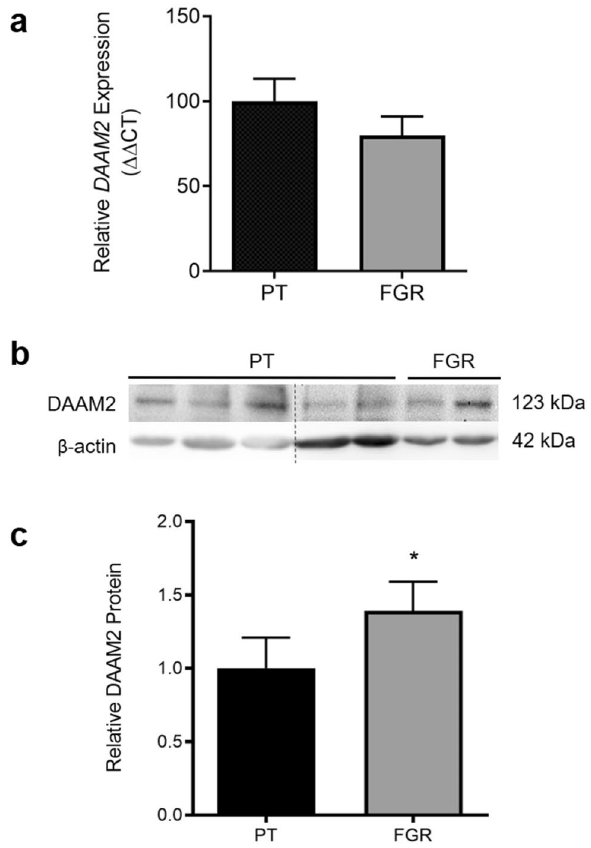
Figure 3. DAAM2 mRNA and protein in preterm placental tissue (≤ 34 weeks). ( a ) DAAM2 mRNA expression assessed by qPCR. ( b ) Representative western blot and ( c ) densitometric analysis of DAAM2 protein. DAAM2 mRNA expression was not significantly changed in fetal growth restricted (FGR; n = 14) tissue compared to preterm control (PT; n = 10) tissue. Relative levels of DAAM2 protein were significantly higher in fetal growth restricted (n = 16) placental tissue compared to preterm control (n = 9) tissue. Protein and mRNA data presented as fold change from control ± SEM. *p < 0.05. Full western blot images are presented in Supplementary Fig. S3.